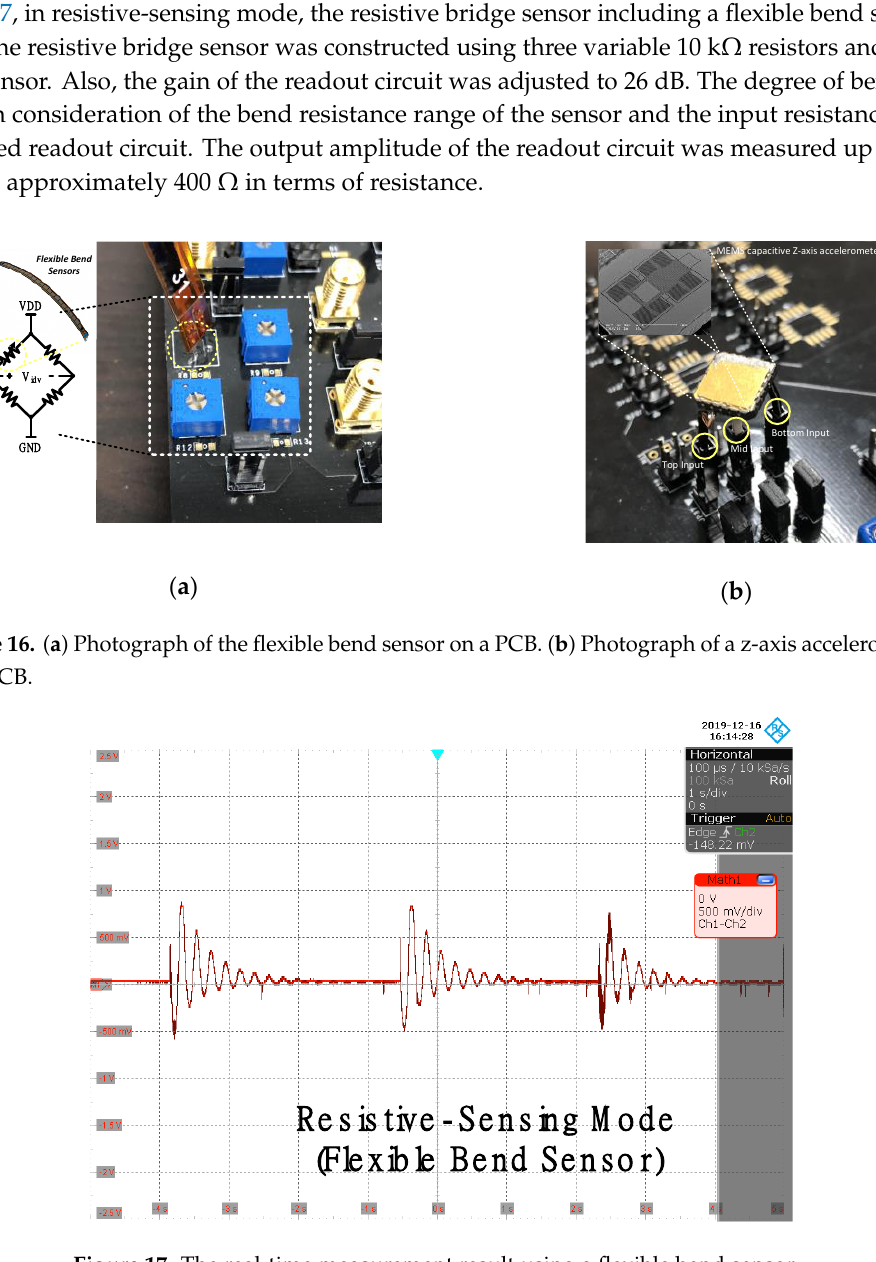
(Z-Axis Accelero m eter)